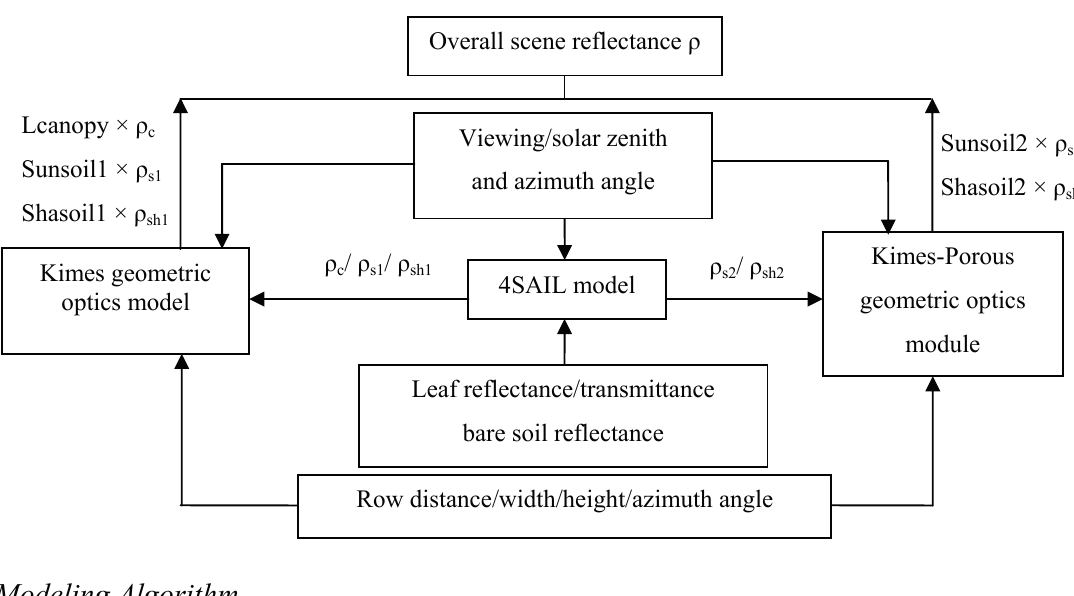
Figure 1. Framework for developing the 4SAIL-RowCrop